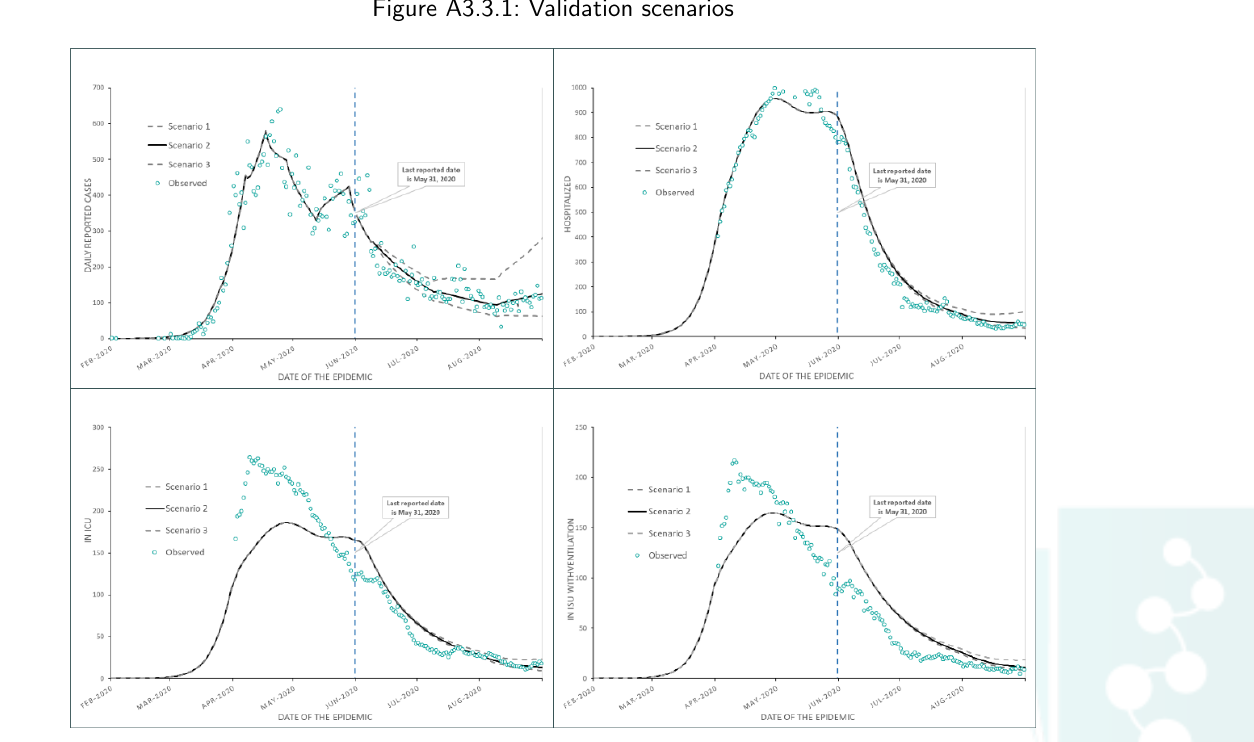
Figure A3.3.1: Validation